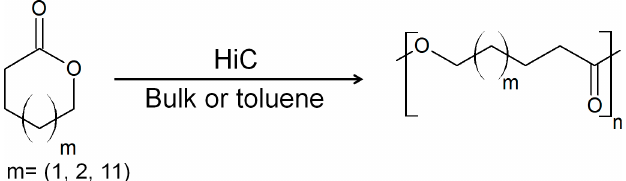
Figure 3. Schematic representation of Ring Opening Polymerizations (ROP) catalyzed by HiC both in toluene and solvent free